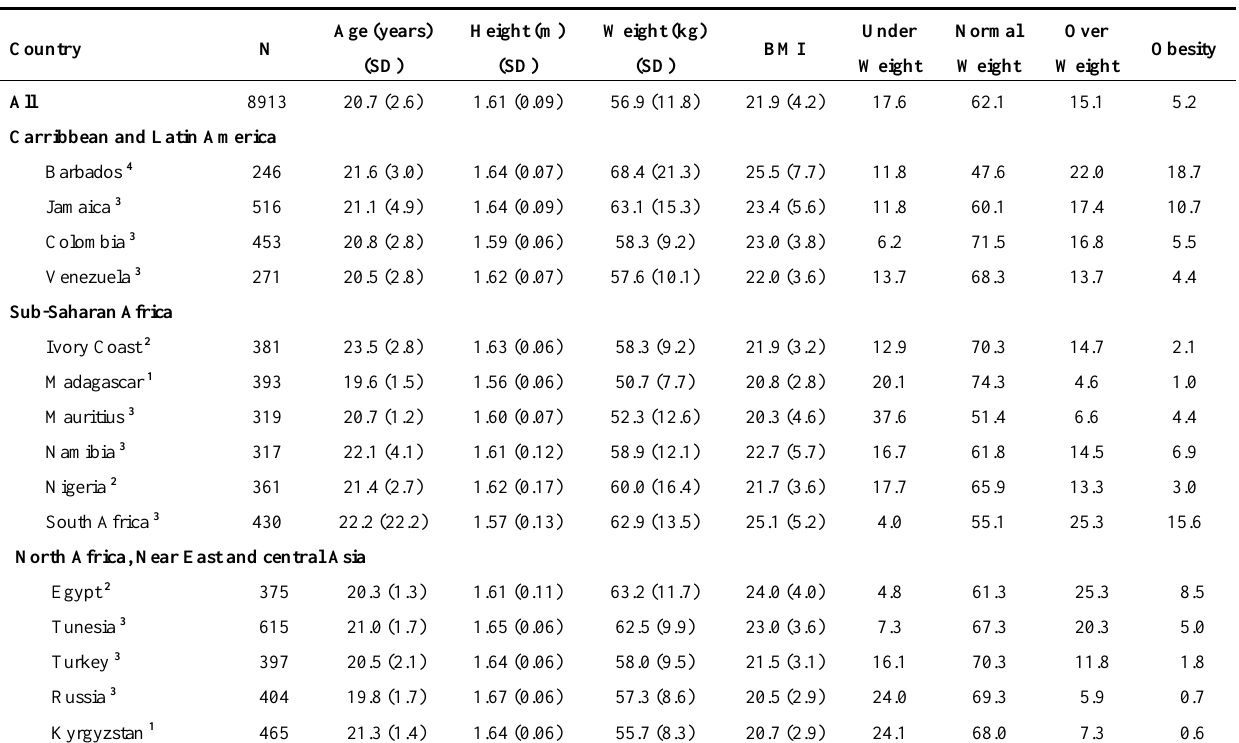
Table 2. Reported mean age, measured height and weight, and calculated BMI and weight status among female university students from 22 low and middle income and emerging economy countries,